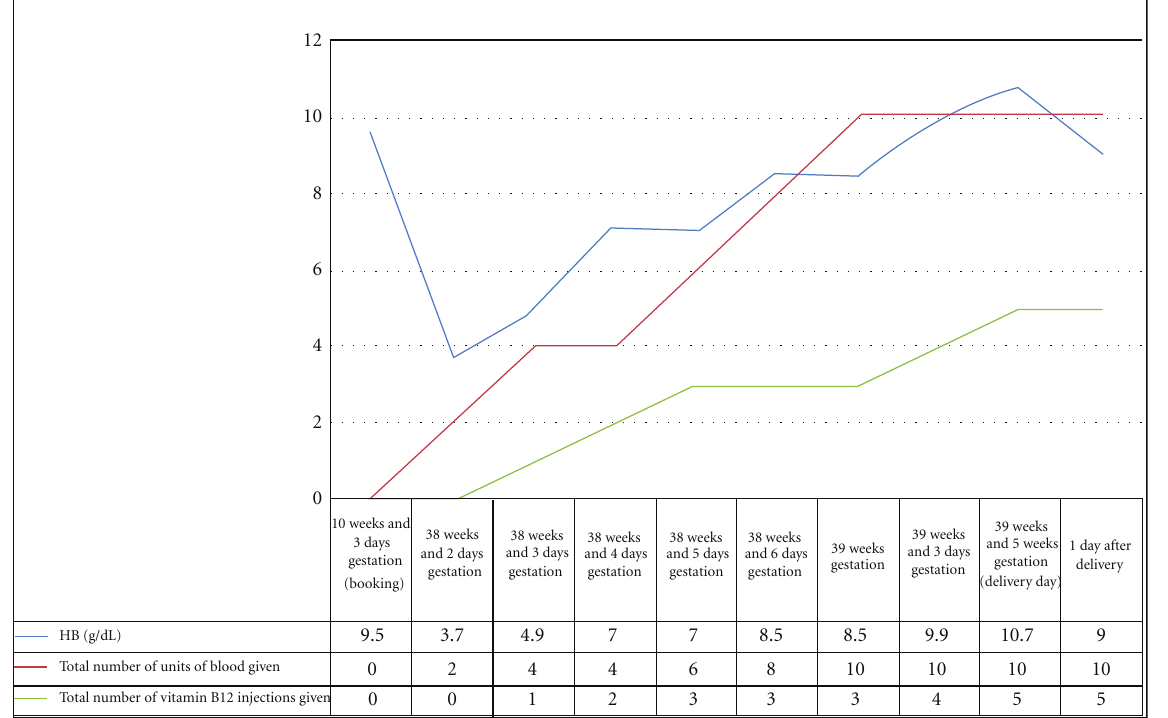
Figure 1: Graph showing patients’ haemoglobin levels, and total number of units of blood and vitamin B12 injections given.